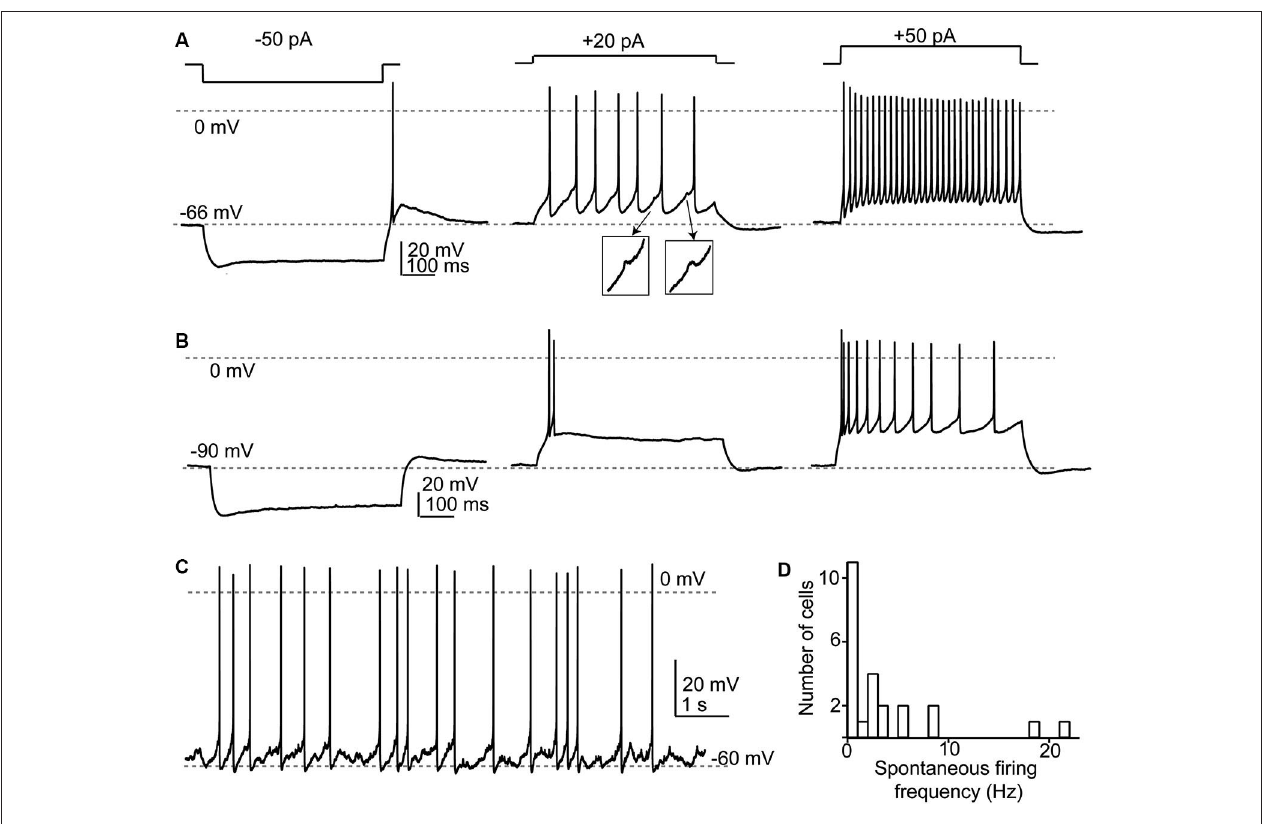
negative membrane potentials, SSCs generated spike bursts or exhibited an adapting profile of spiking. (C) Example of spontaneous spike activity that was apparent in about half of recorded SSCs. (D) Broad frequency distribution of spontaneous spiking in a population of 29